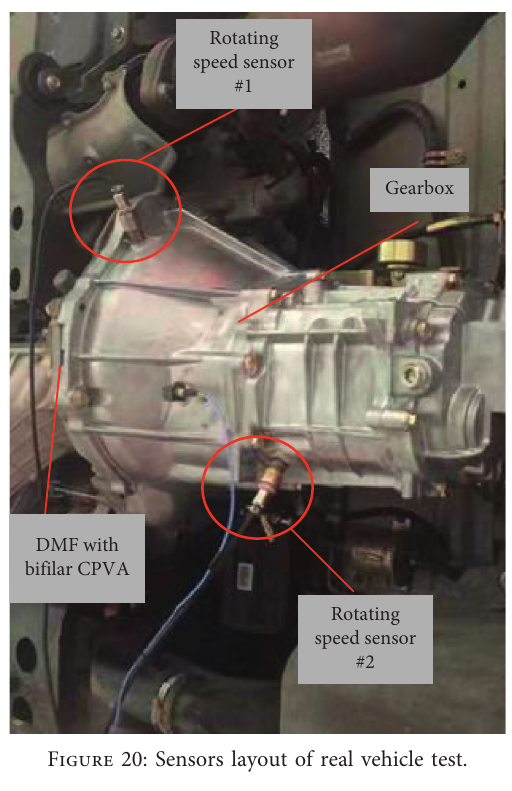
Figure 20: Sensors layout of real vehicle test.